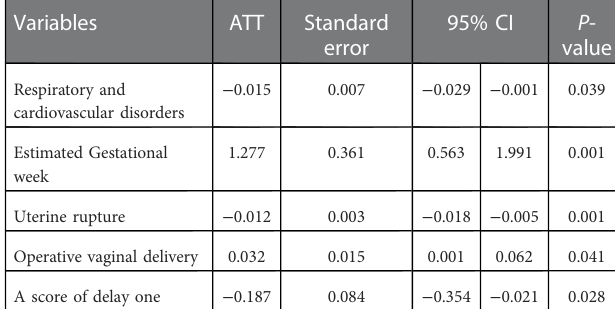
TABLE 7 Average treatment effects on the treated (ATT) 4 and more ANC visits on maternal and perinatal health in Ethiopia, 2021.